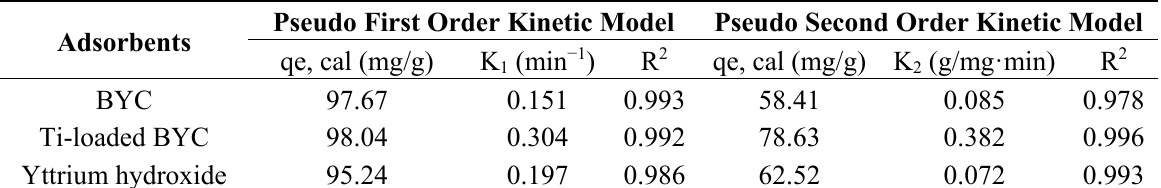
Table 2. Pseudo first order and second order kinetic constant of BYC, Ti-loaded BYC and yttrium hydroxide.